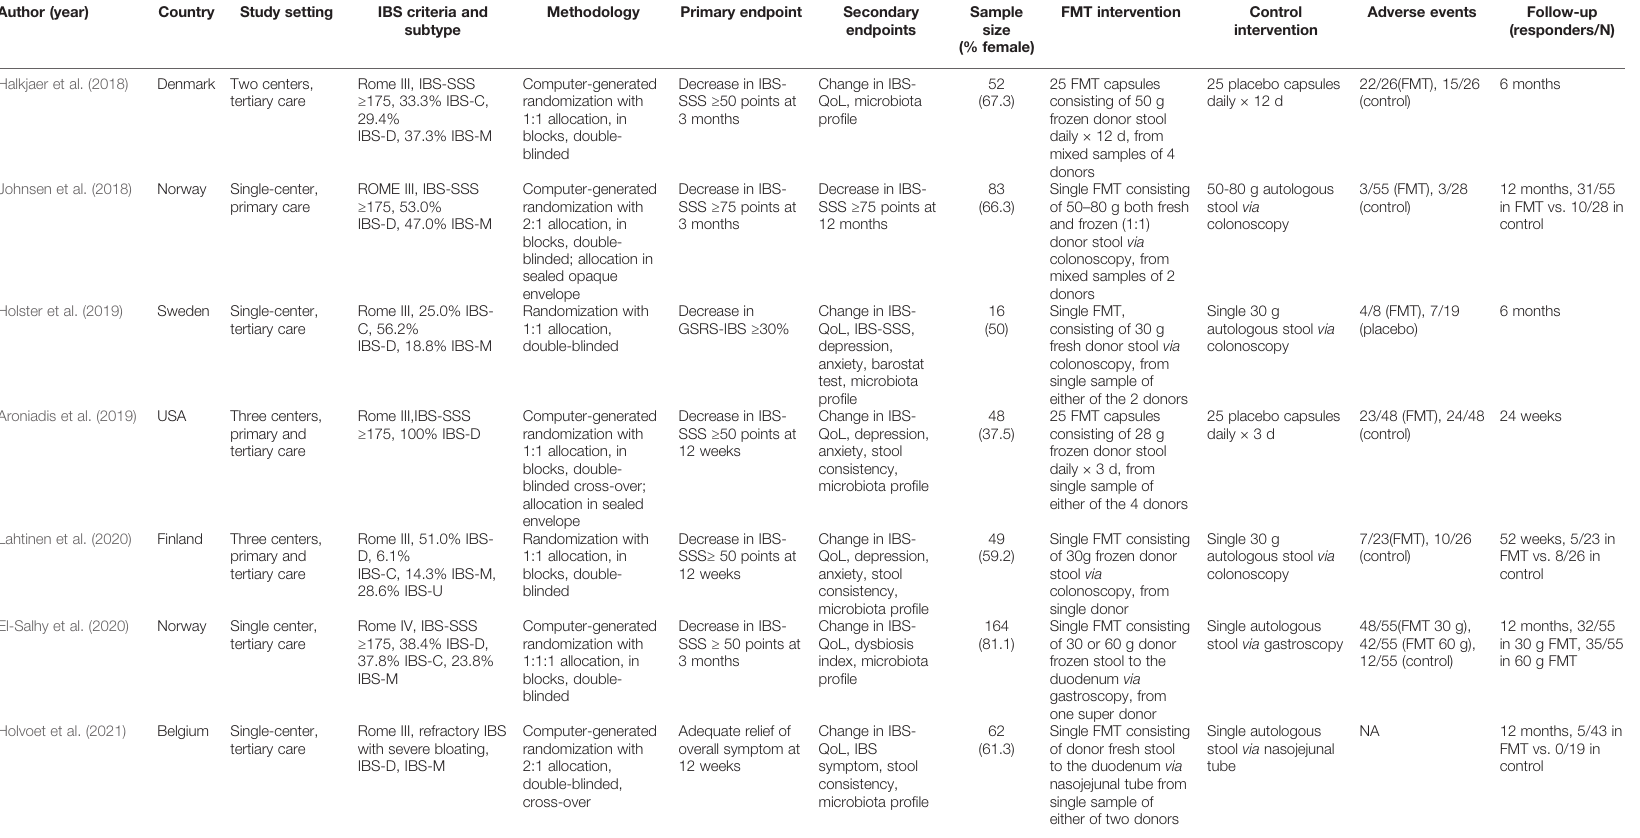
TABLE 1 | Characteristics of included